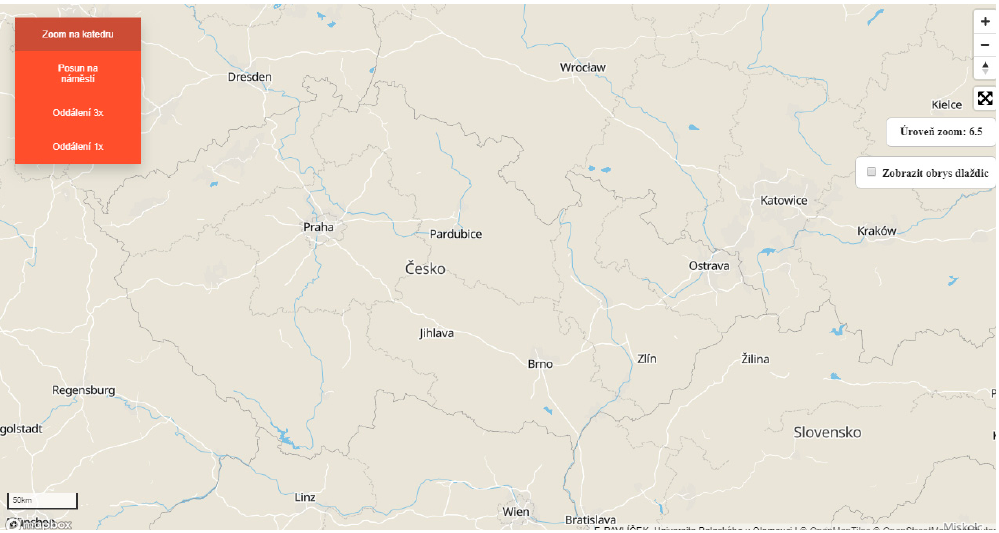
Figure 3. Front-end interface of the pilot studies.